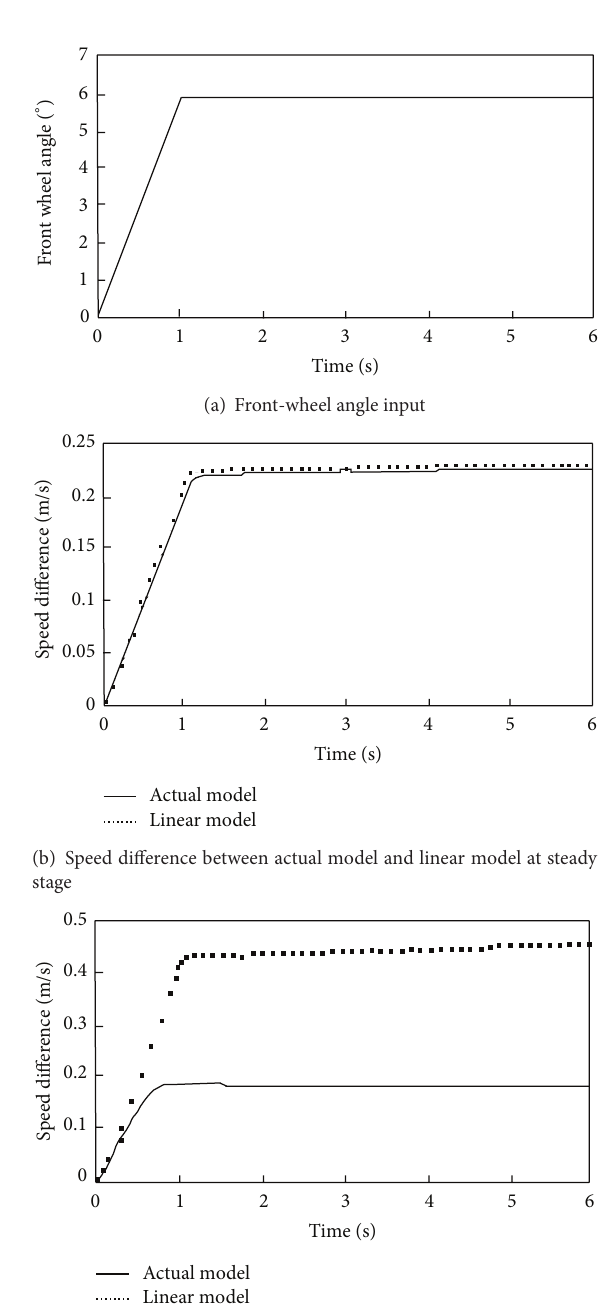
Figure 2: Speed difference between actual model and linear